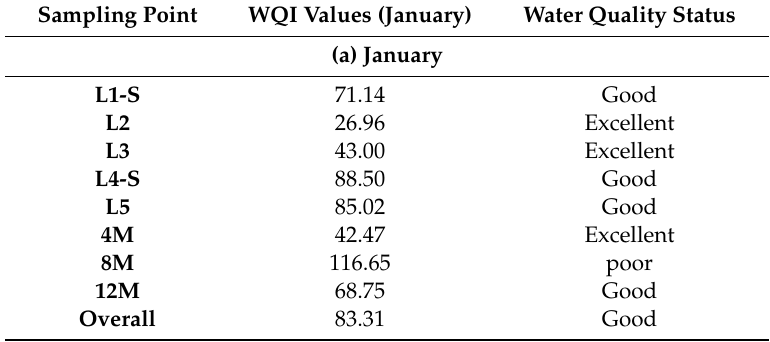
Table 14. Water quality status at various sampling points and the overall status of